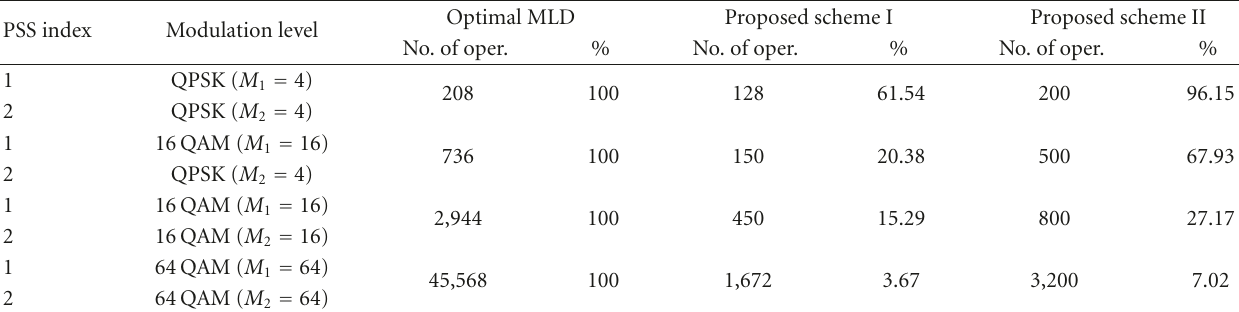
Table 5: Complexity comparison for real addition operations ( N t = N r = 2, per one